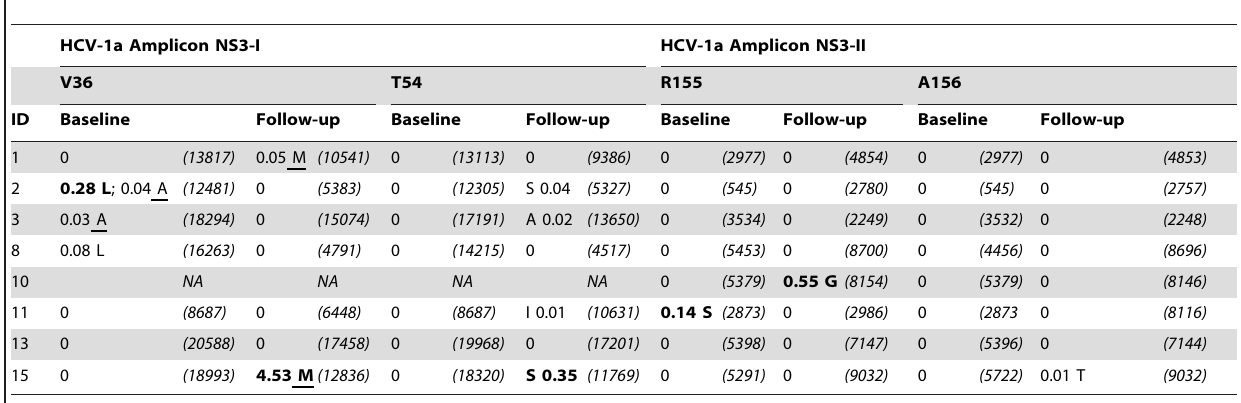
Table 3. HCV-1a NS3 UDPS mutation